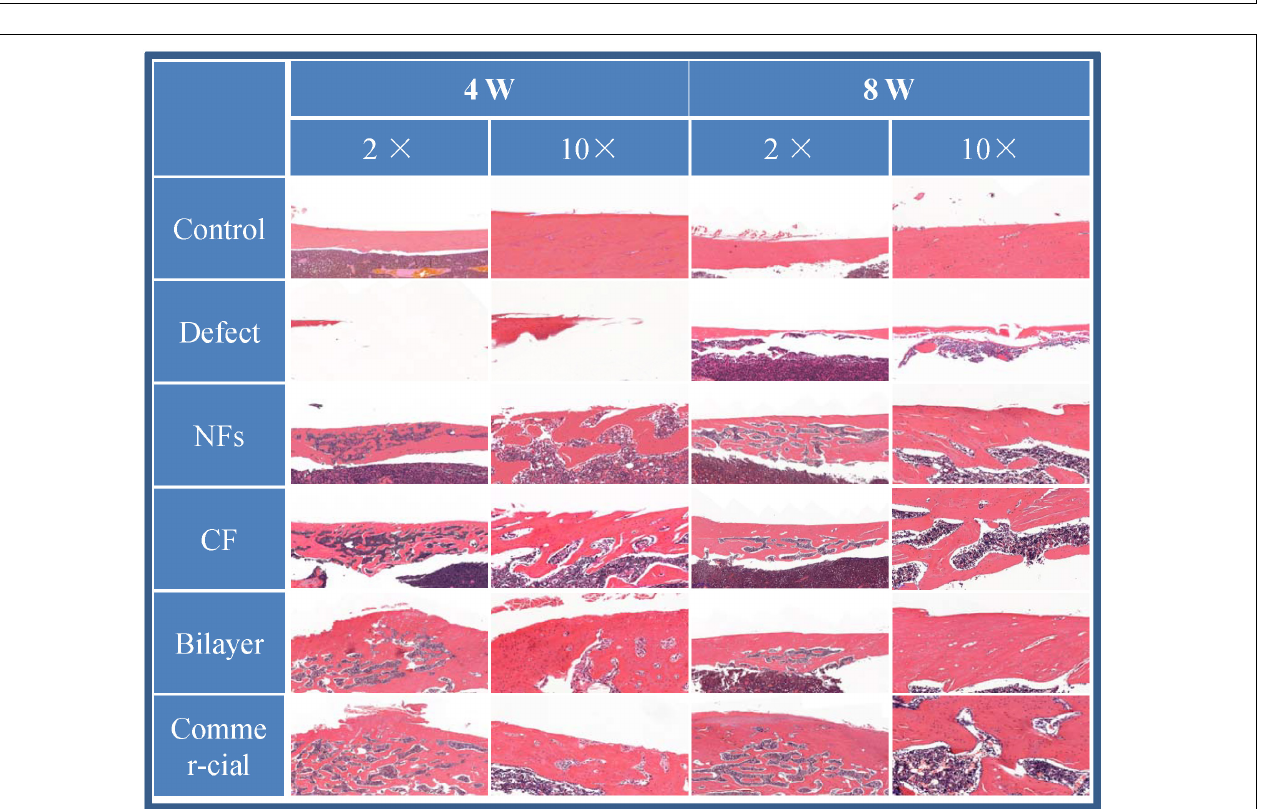
FIGURE 9 | Images obtained by 3D CT of bone regeneration at the bone–implant interface in rats at 4 and 8 weeks.